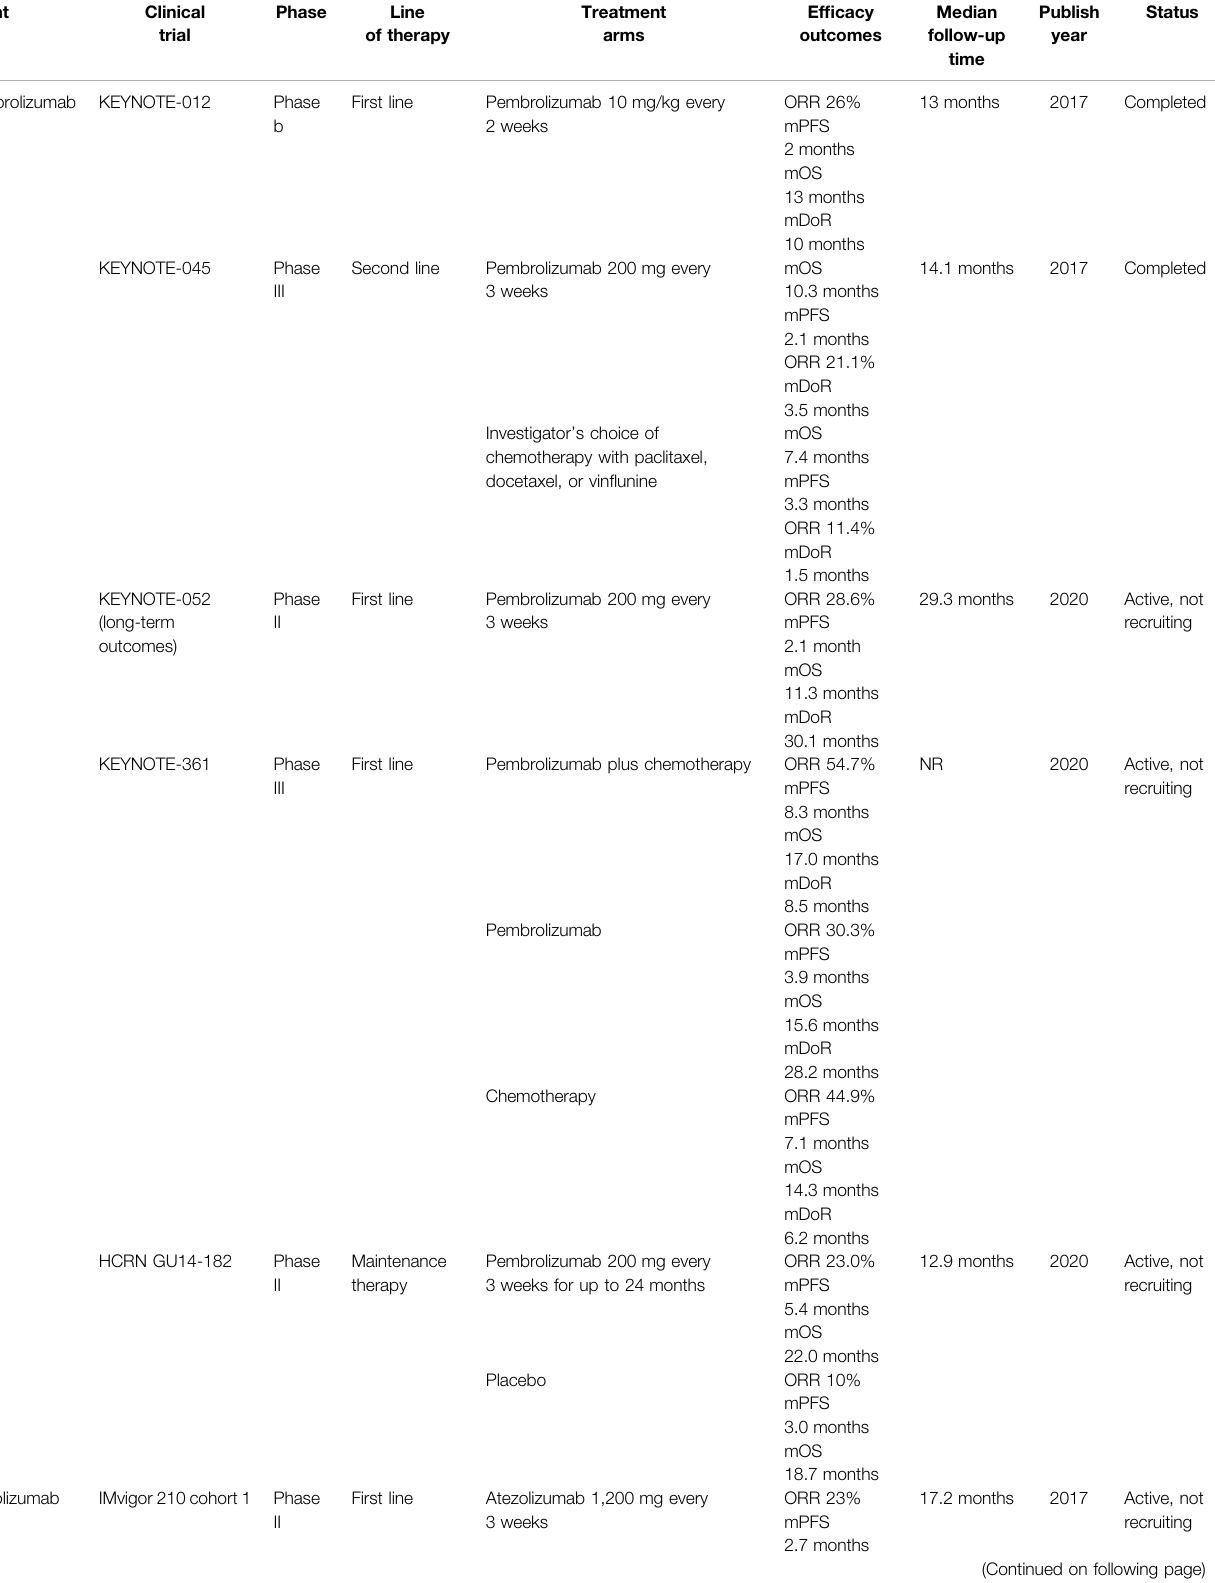
TABLE 2 | Key clinical trials ’ ef fi cacy data of ICIs in patients with